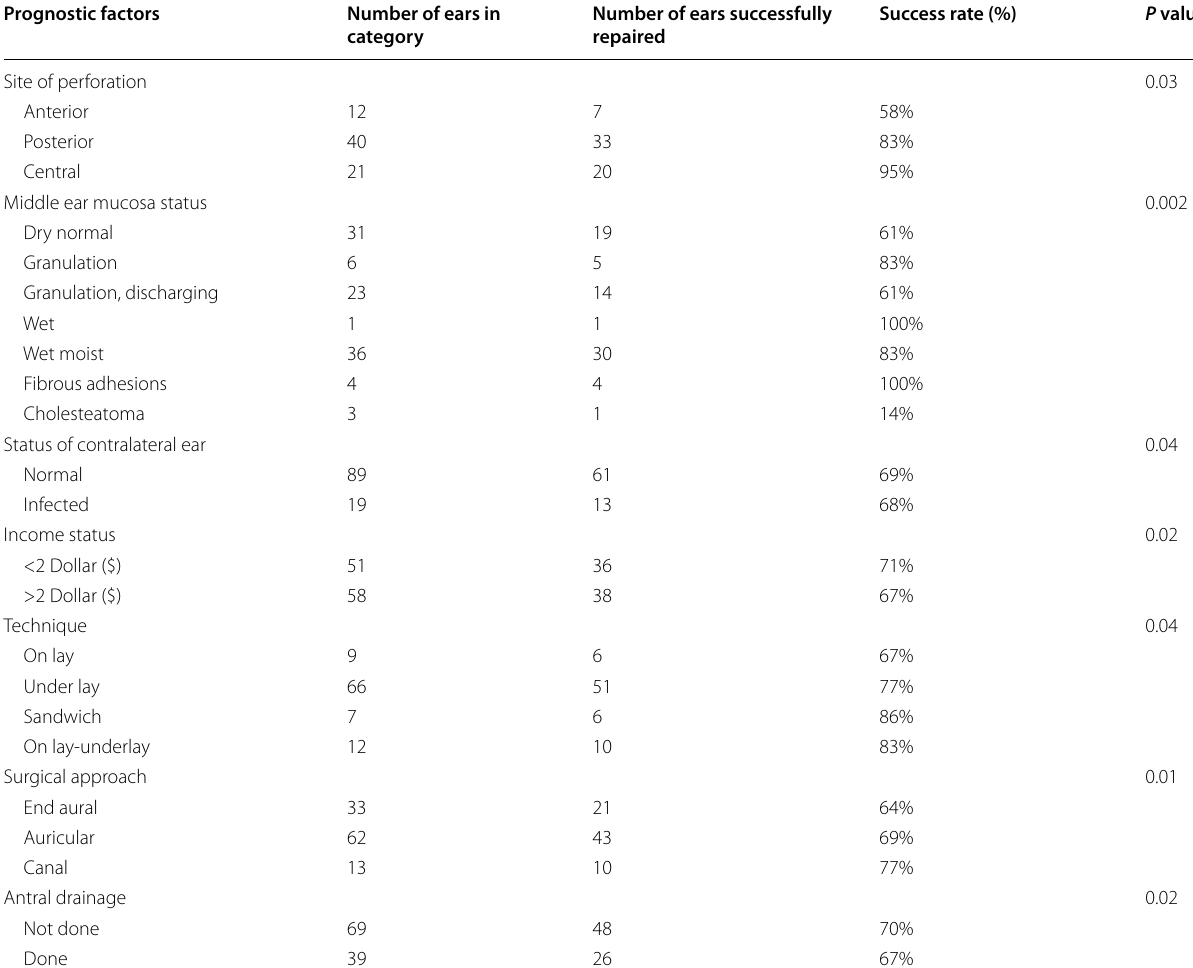
Table 1 Success prognostic factors in the current study: significant variables Prognostic factors